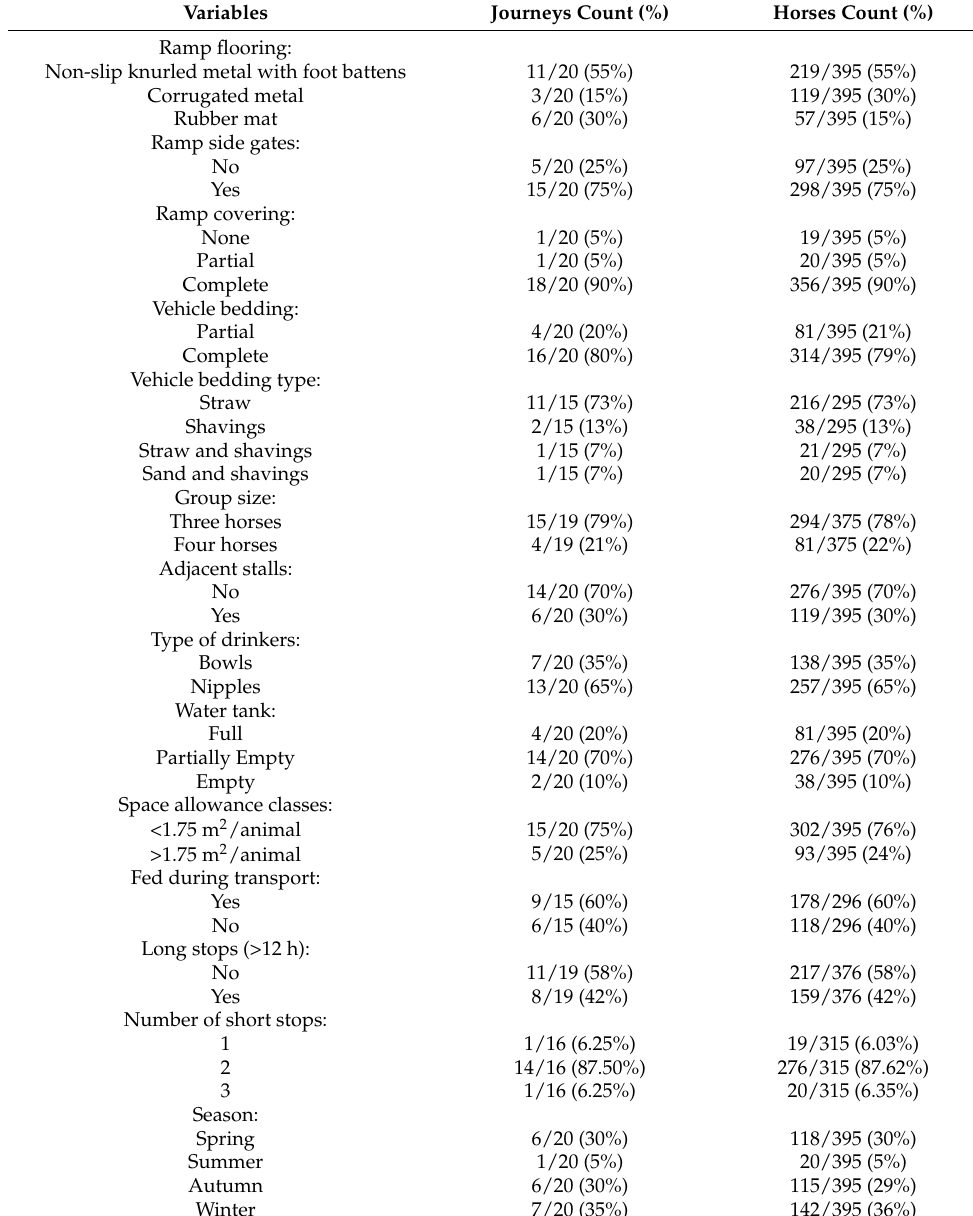
Table 9. Frequency table of journeys ( n = 20) and unbroken horses ( n = 395) for the categorical variables related to the vehicle and journey